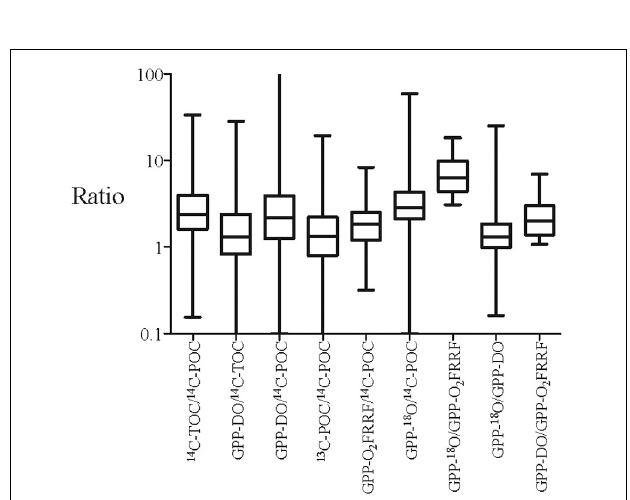
FIGURE 2 | Box plot showing the variation of the primary production ratios measured by two different methods concurrently. The boxes encompass the lower (25%) and upper (75%) quartiles, and the central line shows the median ratio, and the whiskers go down to the smallest value and up to the